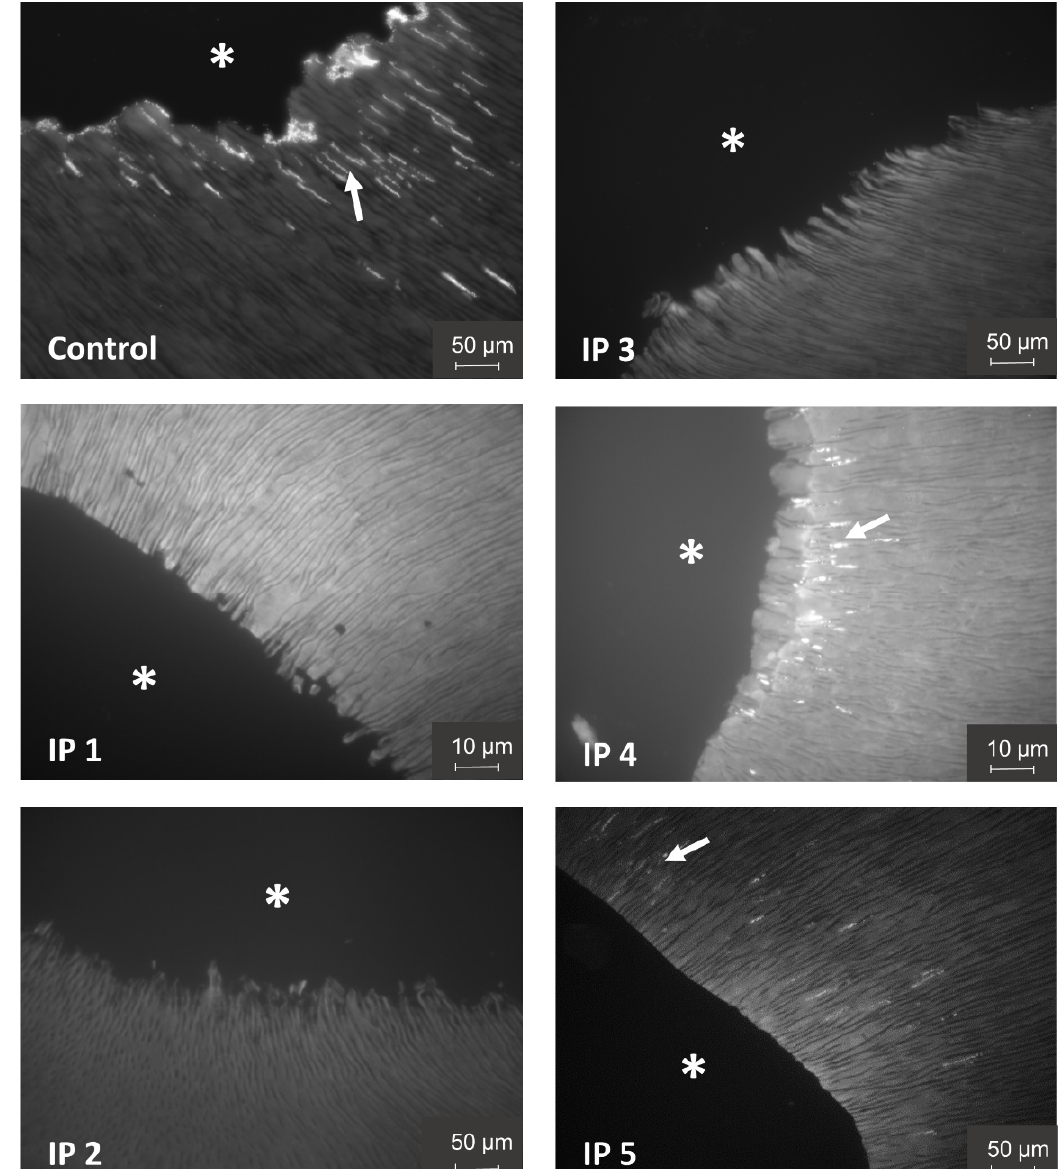
Figure 4. Representative sections of root canal slices of DAPI-stained fluorescent microscopical images portraying the bacterial load and distribution of the control and after applying different irrigation protocols. Bacterial infection in the dentinal tubules ( → ) was mainly detected in the control group and to lower levels in the irrigation protocols IP 4 and IP 5 near to the root canal lumen (*) while in IP 1, IP 2 and IP 3 almost no bacteria were detected.